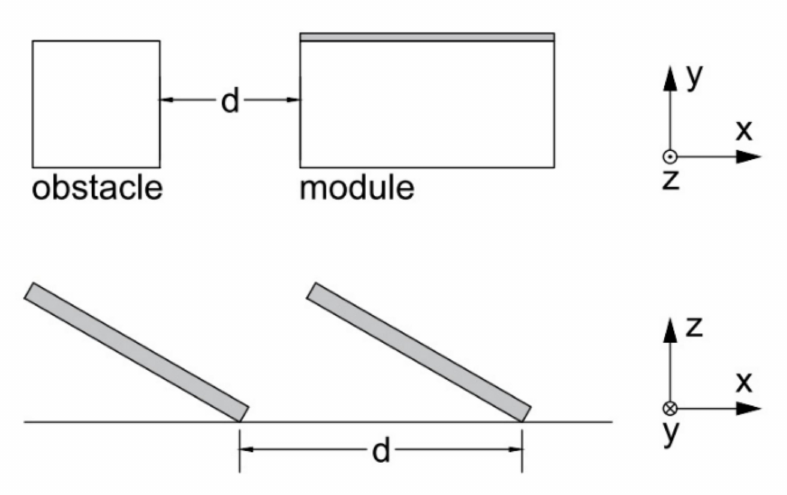
Figure 21. Geometry of the shading situations where d is a varied parameter.